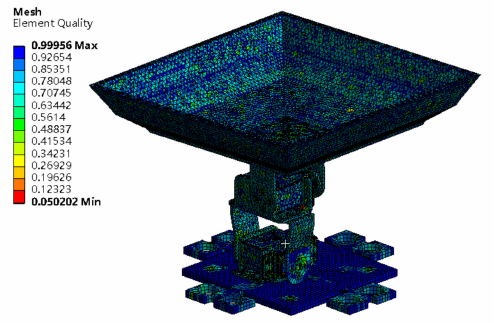
Figure 9. Meshing quality. The overall quality of the mesh ranges between 0.85 and